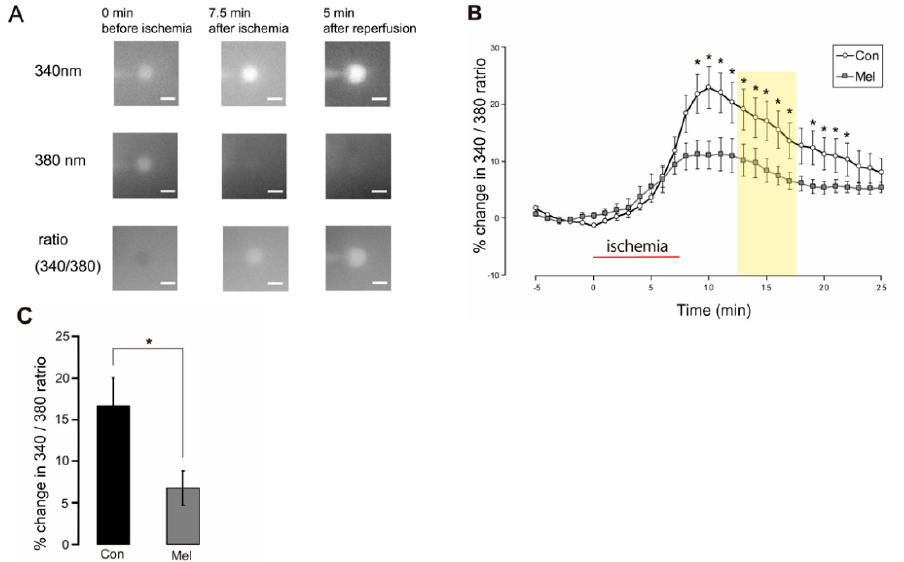
Figure 5. Effect of melatonin-induced PostC on cytosolic Ca 2+ concentration after ischemia-reperfusion. ( A ) Representative microphotographs showing changes in Fura-2 emissions resulting from excitation at 340 and 380 nm for the control group. The elevation in the Fura-2 ratio (340/380 ratio) represents an increase in cytosolic Ca 2+ concentration. Scale bars = 10 μ m. ( B ) Course of changes in the Fura-2 ratio during pre-anoxic, anoxic, and reperfusion periods. Percentages are relative to the mean value observed during the 5 min of the pre-anoxic period. The red horizontal bar indicates the ischemic period. The timeline in the graph is set to 0 min at the start for the ischemic load. The increase in intracellular Ca 2+ concentration after reperfusion is significantly inhibited by melatonin-induced PostC ( p < 0.05). The yellow band represents the period used for statistical analysis. ( C ) Each vertical rectangle and error bar indicate percentage change in the Fura-2 ratio during 5–10 min after 7.5 min of ischemia (yellow band in ( B )) and SEM, respectively. Asterisks indicate significant difference in t-test (* p < 0.05). Con—control; Mel—melatonin.